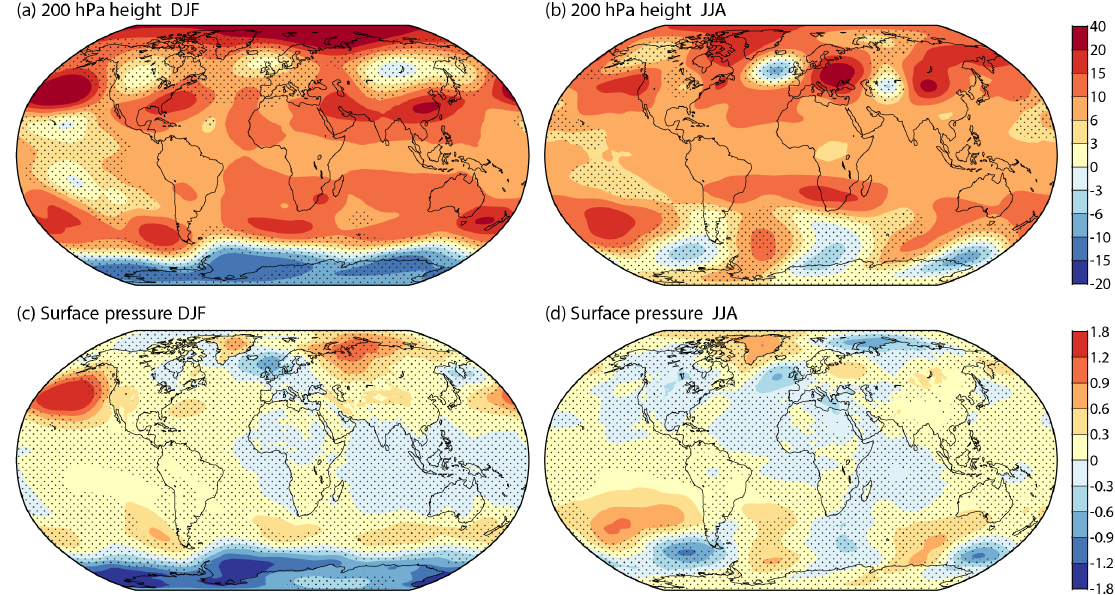
Figure 21. Trends in geopotential height (m per decade) and surface pressure (hPa per decade) derived from least squares linear fits of seasonal mean deviations from average values for each DJF and JJA in the period June 1979 to February 2022. (a) 200hPa height for DJF, (b) 200hPa height for JJA, (c) surface pressure for DJF and (d) surface pressure for JJA. Dots show where the 95% confidence interval is two-signed. Contour intervals differ from those used in Fig.